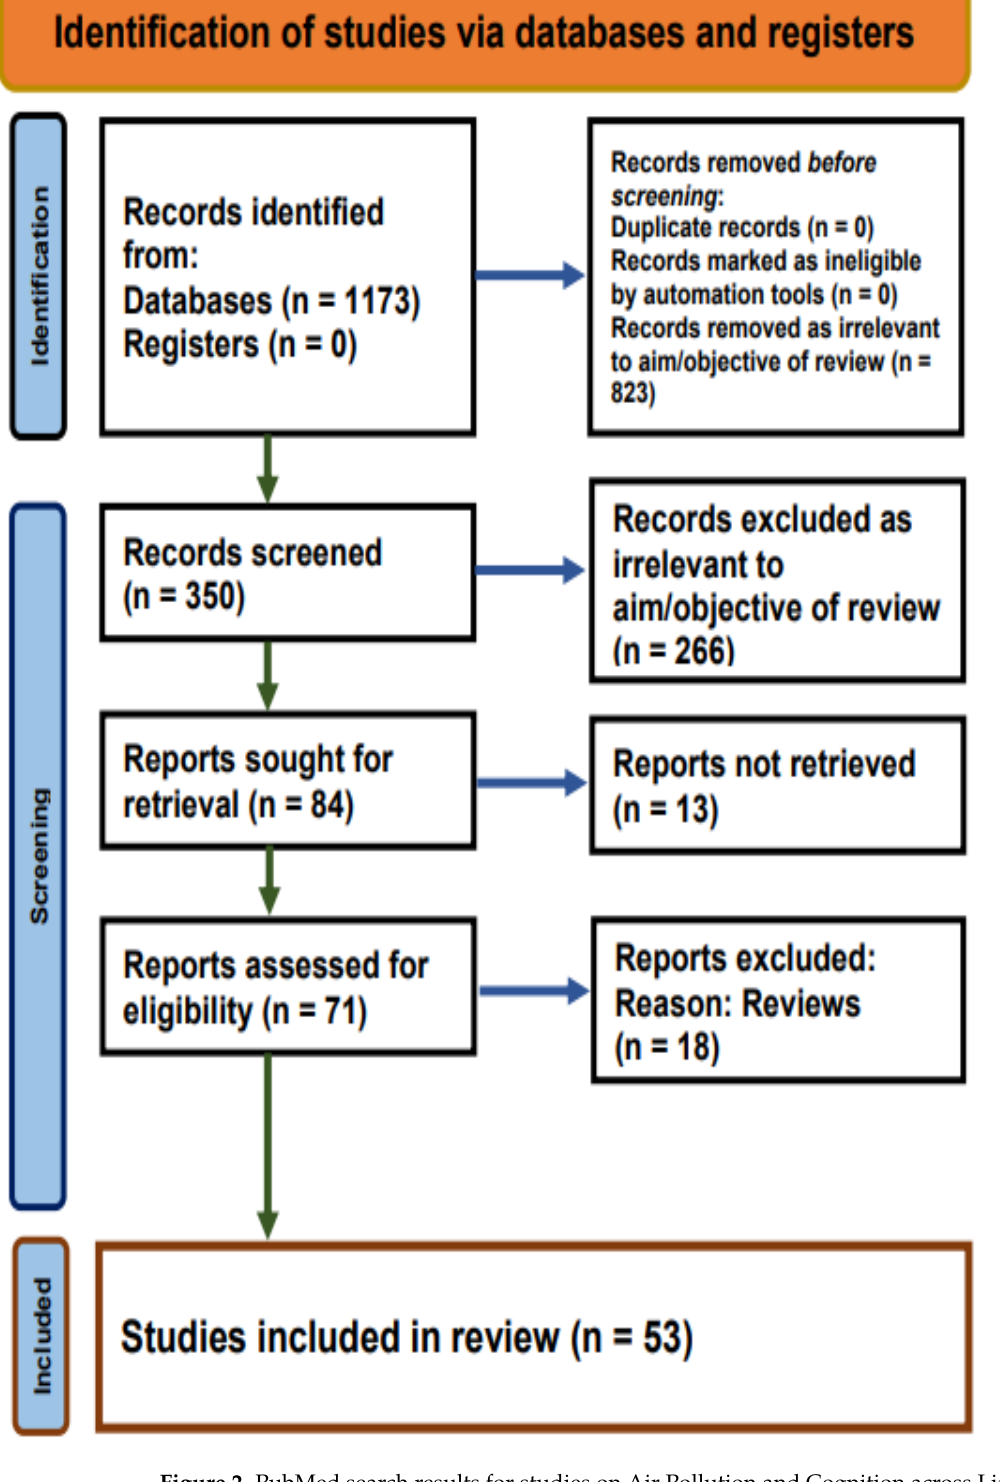
Figure 2. PubMed search results for studies on Air Pollution and Cognition across Life-Course.